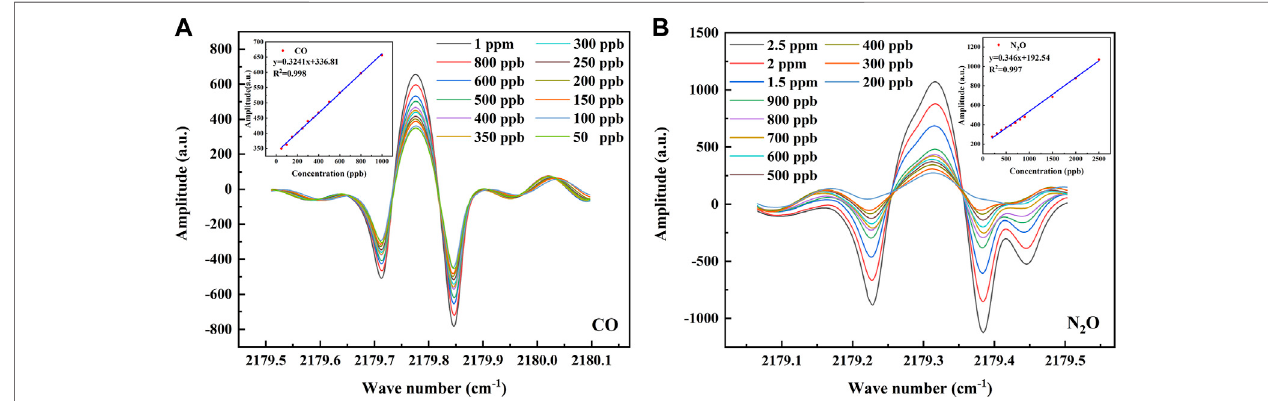
FIGURE5|(A) The2fsignalatCOconcentrationsof50 – 1000ppband thelinearrelationshipbetweenthesetconcentrationsofCOandits2fpeak-to-peak value. (B) The 2f signal at N 2 O concentrations of 200 – 2500 ppb and the linear relationship between the set concentrations of N 2 O and its 2f peak-to-peak